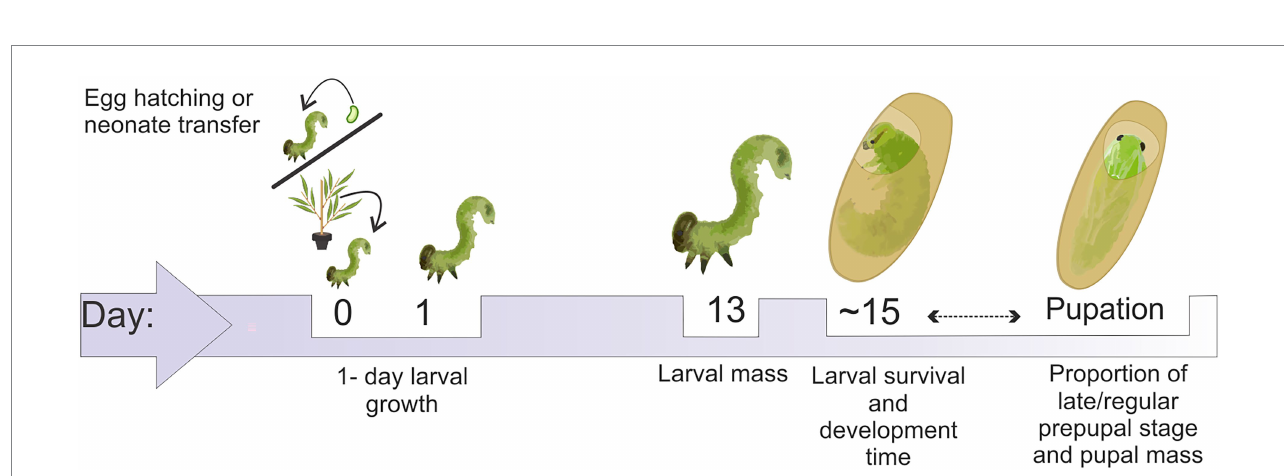
FIGURE 2 Variables of N. oligospilus performance determined on oviposited and non-oviposited willows. Numbers indicate the larval development day in which the measurement was registered. Day 0 refers to egg hatching or neonate transfer from non-experimental plants. Prepupal development time (double headed arrow), is the time period between cocoon spinning (ca. day 15) and day of pupa formation